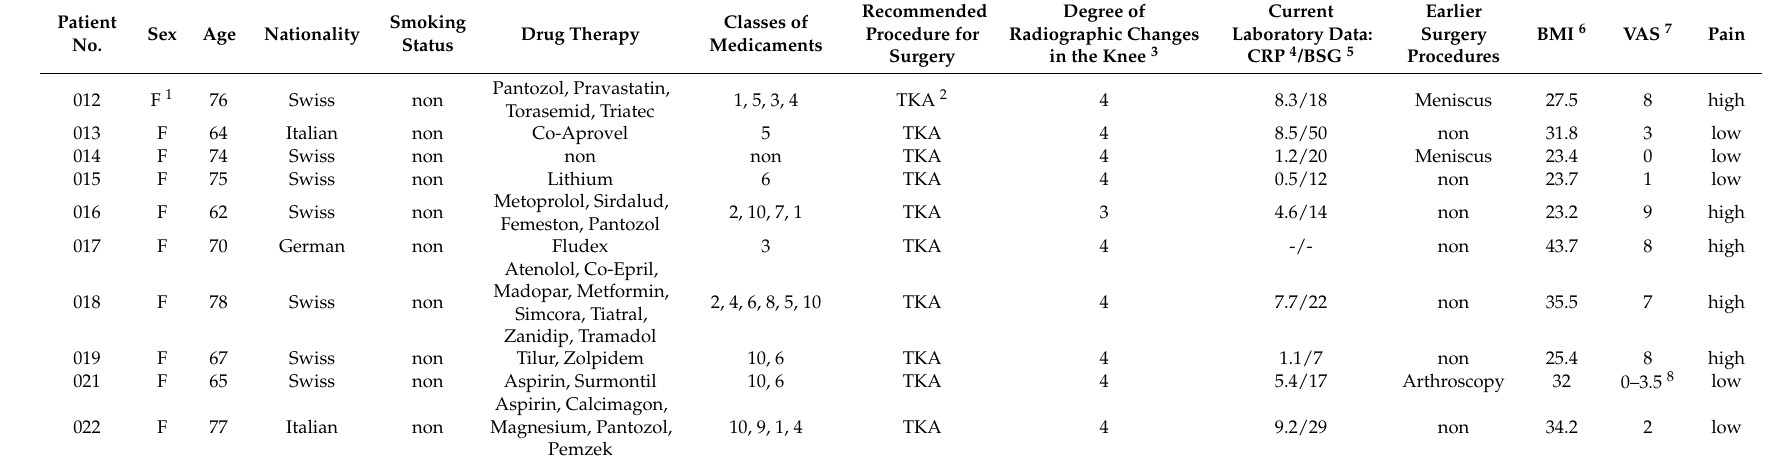
Table 1. Information about the patients enrolled into